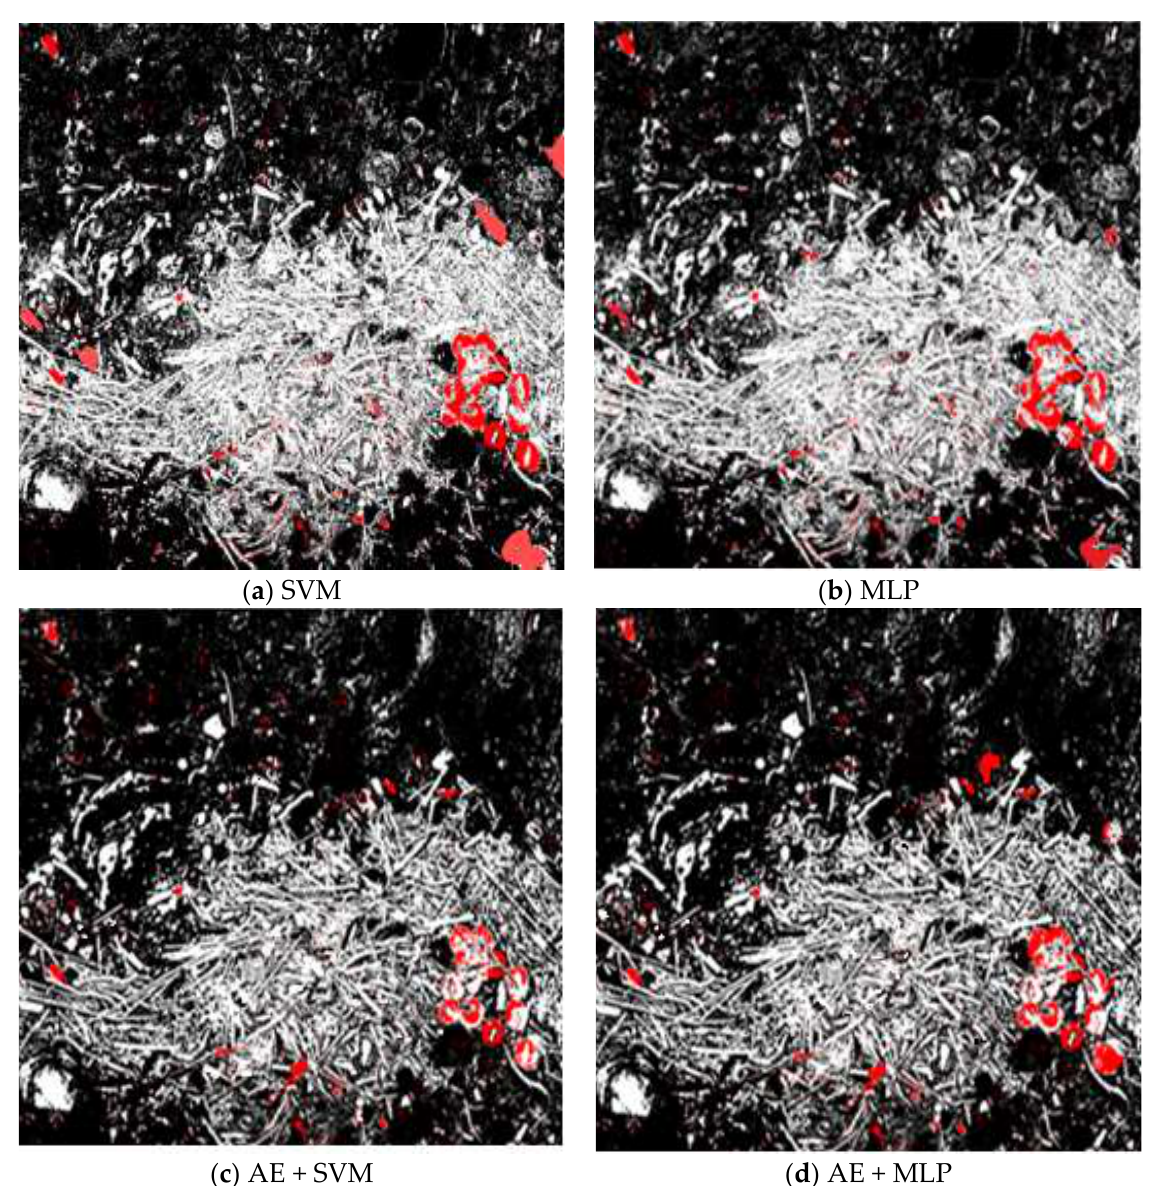
Figure 7. Thematic maps for different model outputs.